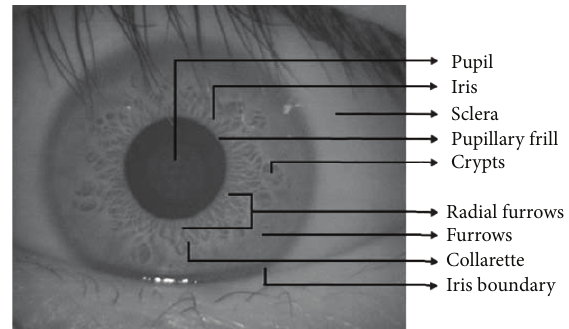
Figure 4: The complex textural patterns of